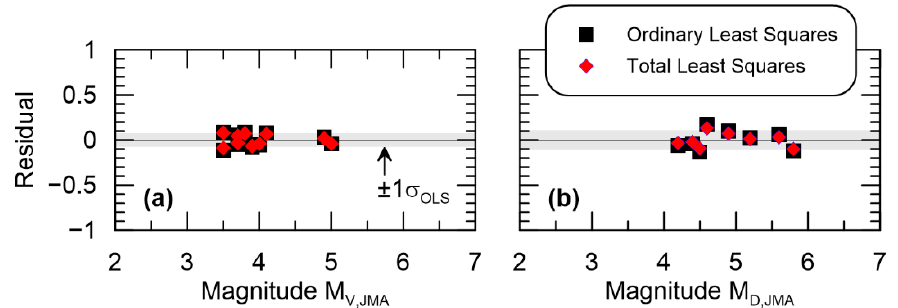
Figure 9. Regression residuals for ( a ) M V,JMA and ( b ) M D,JMA . The shaded regions represent ±1 σ from OLS regression.